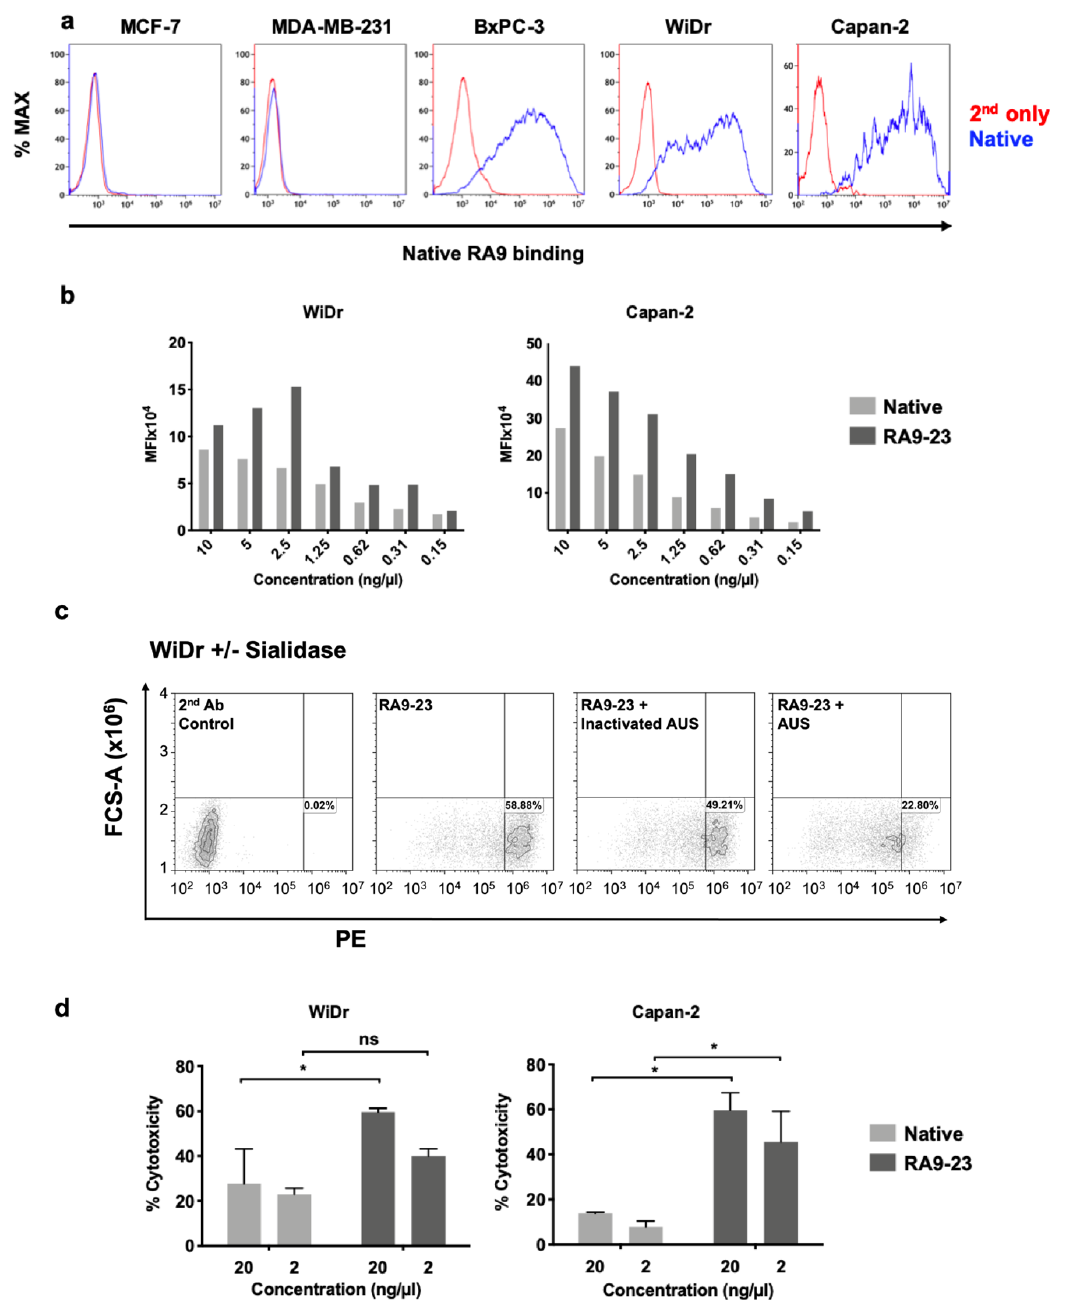
Figure 7. Antibody binding and cytotoxicity against cancer cells. ( a ) Binding of native antibody was examined by FACS against di ff erent cancer cell lines at 10 ng / µ L (blue), compared to secondary antibody control (red). ( b ) Binding of native and RA9-23 IgGs to SLe a -expressing cancer cells (WiDr and Capan2) was examined by FACS at various concentrations (10–0.15 ng / µ L). ( c ) Specificity of binding to cells